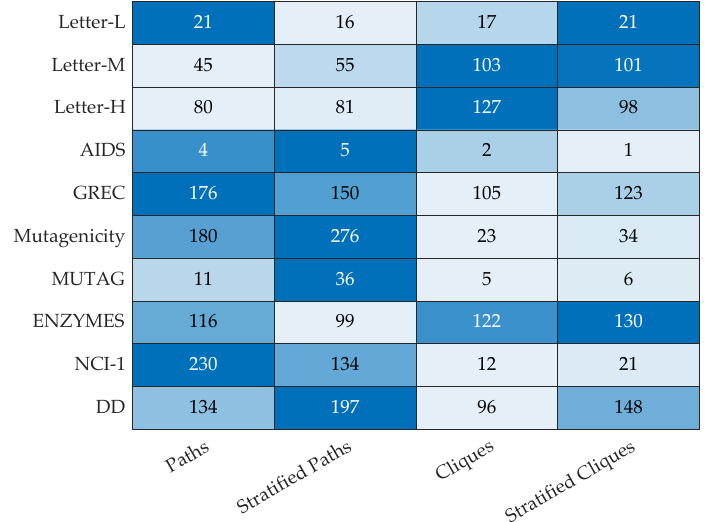
Figure 2. Size of the alphabet after feature